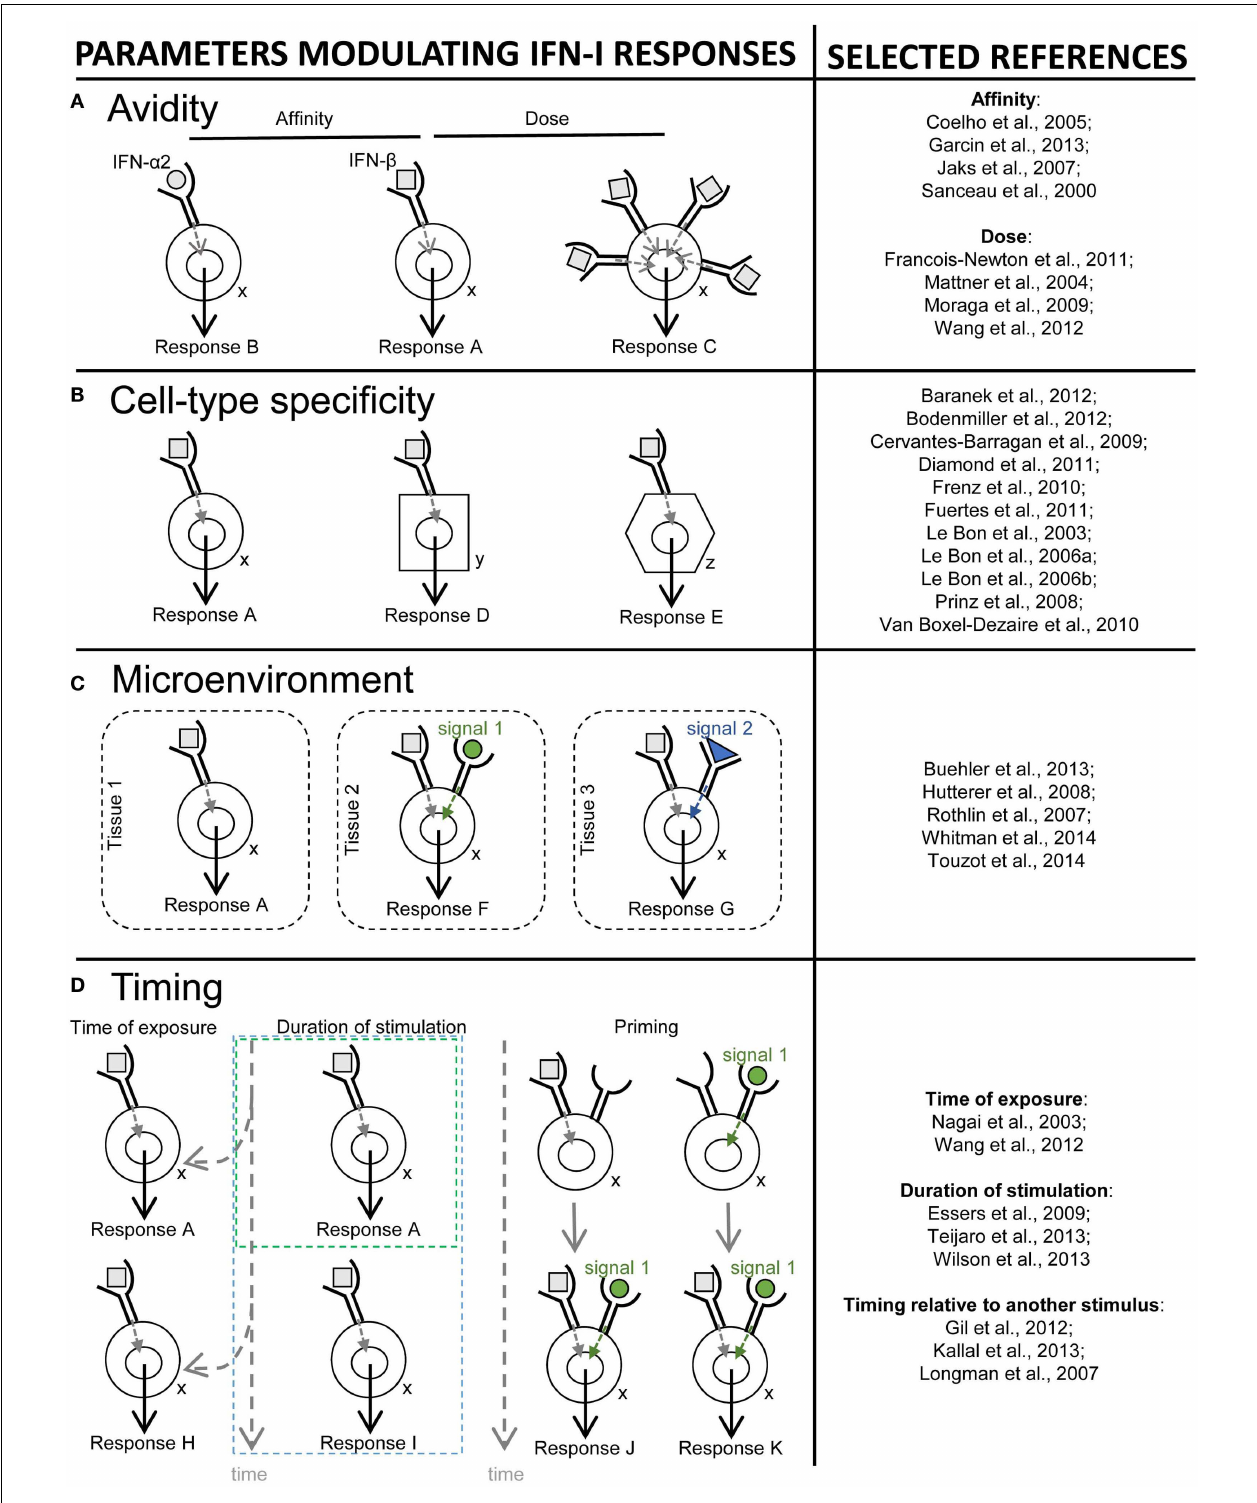
on the right side of the figure. (A) Avidity (a combination of affinity and dose). For example, the affinity of IFN- β for IFNAR1 is 100-times higher than that of IFN- α 2, and IFN β is much more potent in inhibiting cellular proliferation or ( Continued